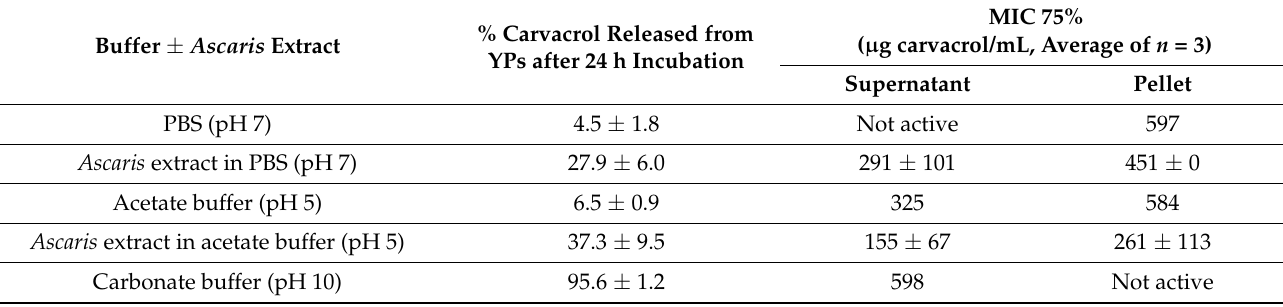
Table 5. Hydrolysis of YP pro-carvacrol in Ascaris suum extract and antibacterial activity on the E. coli of the supernatant containing carvacrol released from the YPs and YP pellet fraction containing residual encapsulated pro-carvacrol. MIC 75% % Carvacrol Released from ( µ g carvacrol/mL, Average of n = 3) Buffer ± Ascaris Extract YPs after 24 h Incubation Supernatant Pellet PBS (pH 7) 4.5 ± 1.8 Ascaris extract in PBS (pH